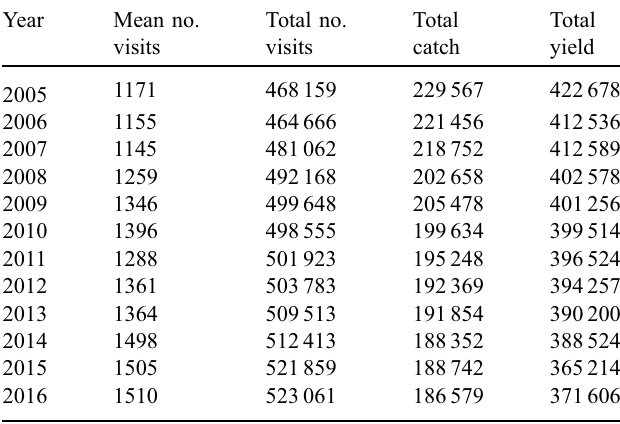
Table 1. Summary of fi shing effort by recreational fi shers on 225 fi shing grounds in the study area. Mean number of fi shing visits per fi shing ground, total number of fi shing visits on all fi shing grounds, and total catch (numbers) and yield (kg) for all species on the studied fi shing